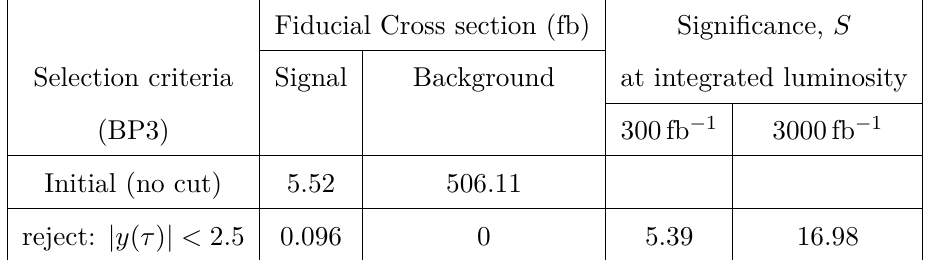
H − → ν τ ν τ τ + τ − ) and the SM background 2 2